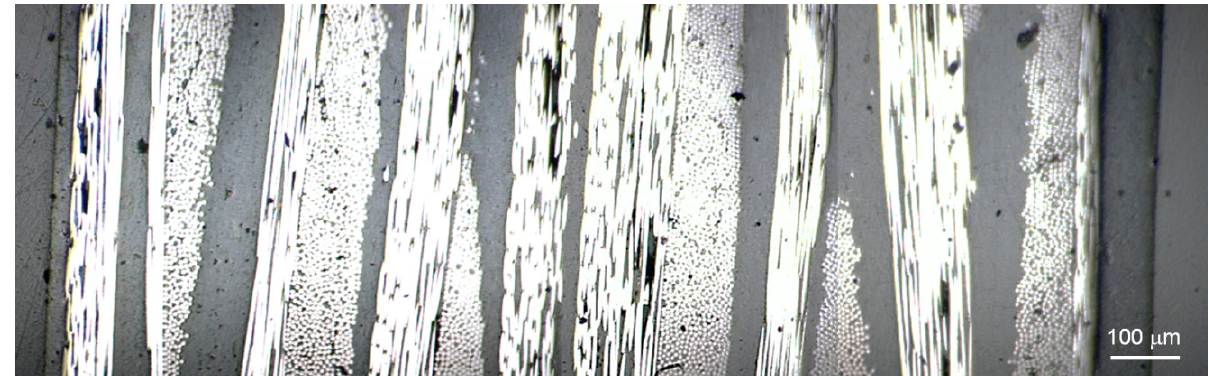
Figure 3 . Optical microscopy image of the cross section of the PEEK-GSPEEK/CF laminate embedded in epoxy resin.